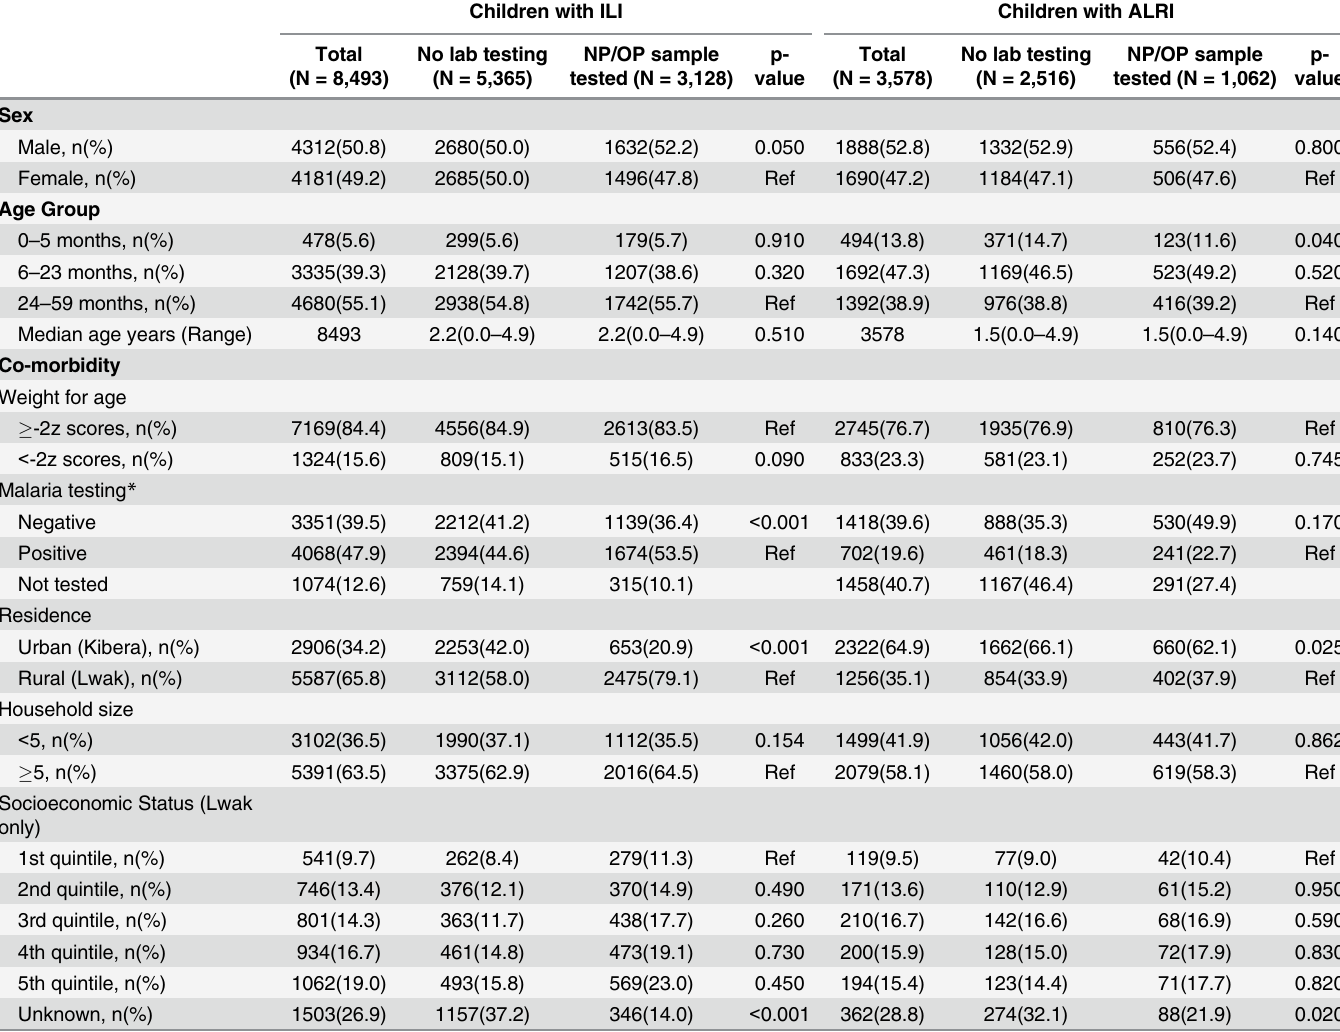
Table 1. Characteristics of Children with Influenza-like Illness (ILI) and Acute Lower Respiratory Tract Illness (ALRI) without Laboratory Testing vs Children with Nasopharyngeal/Oropharyngeal (NP/OP) Sample Tested for Influenza, 2008 –